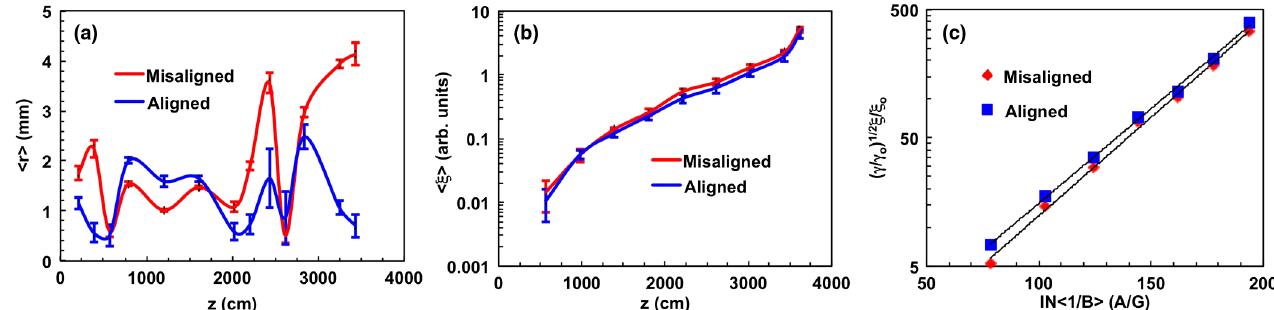
FIG. 9. (a) Measured rms beam centroid offsets, h r i , (b) measured BBU amplitude h ξ i , and (c) comparison of BBU growth along the accelerator for the aligned (blue) and misaligned (red) cases. All are averaged over five shots; error bars indicate shot variations.